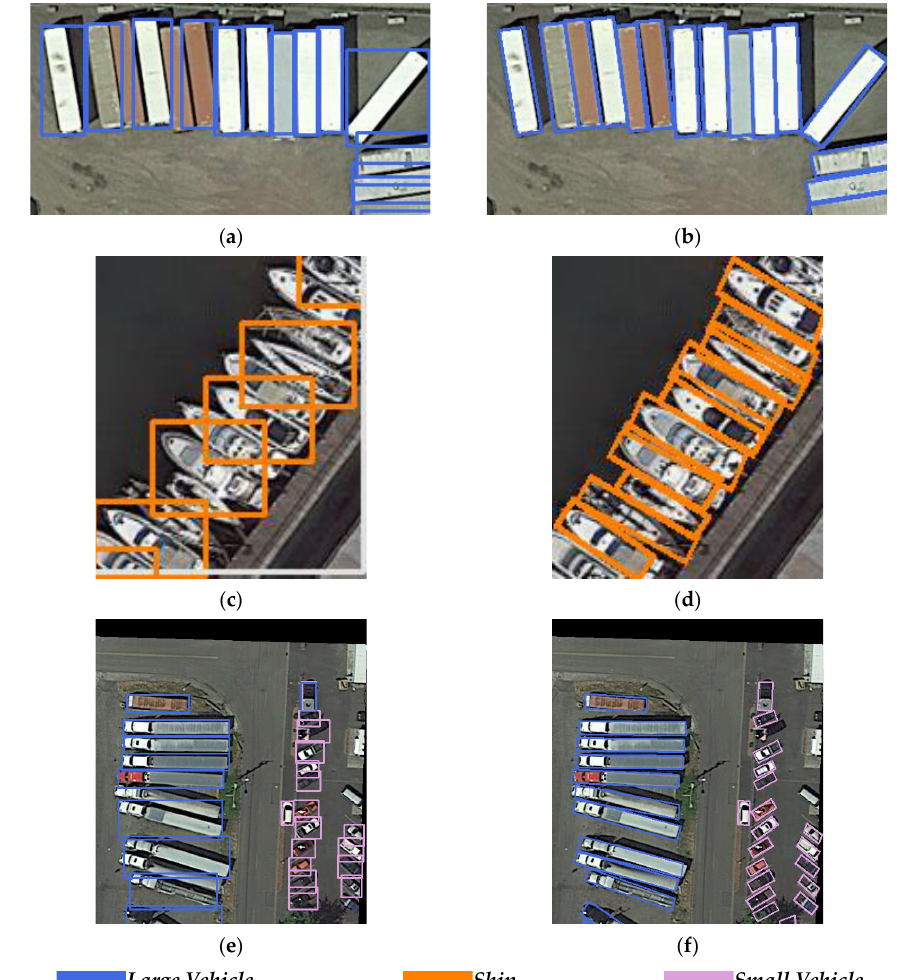
Figure 12. Comparison of horizontal box and oriented box detection result (the threshold score is 0.5). ( a , b ) Large vehicle; ( c , d ) ship; and ( e , f ) large vehicle, small